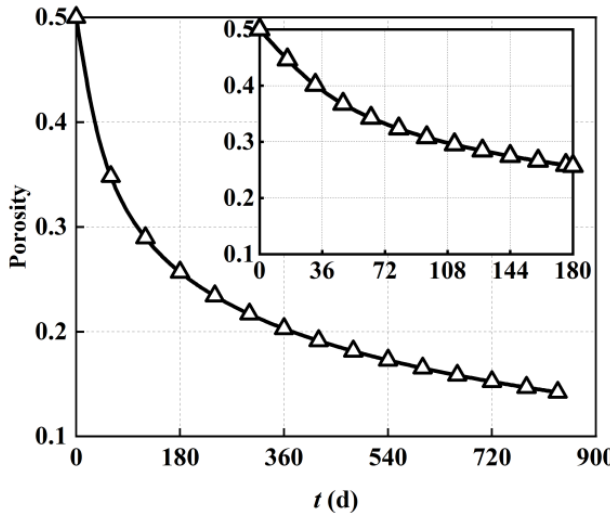
Figure 6. The variation in porous anode electrode porosity over operating time during 20,000 h of steady − state operation.